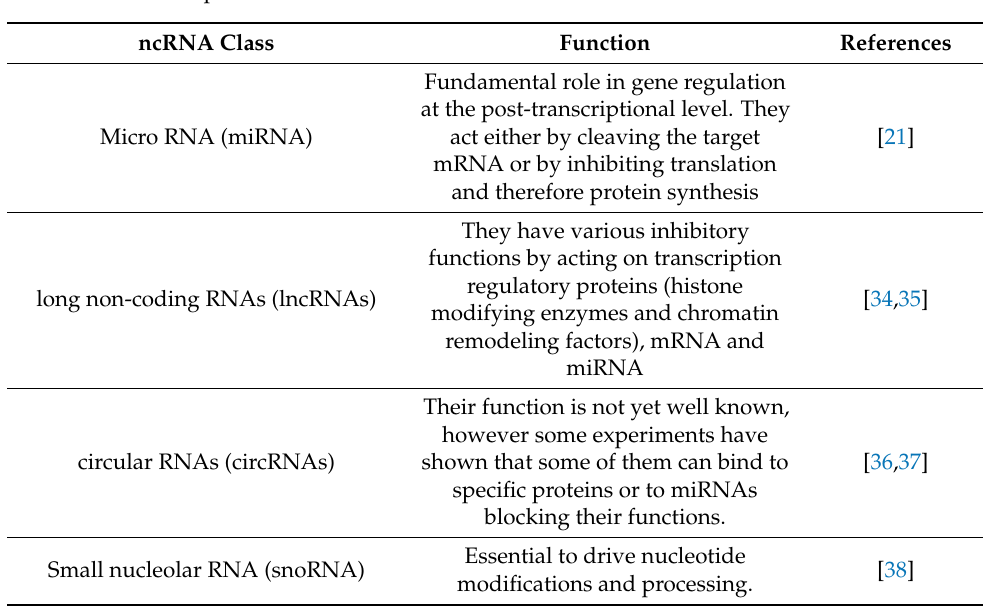
Figure 1. Graphical representation that a miRNA can control several genes ( A ) and that one gene can be controlled by different miRNAs ( B ). Table 1. Brief description of the main